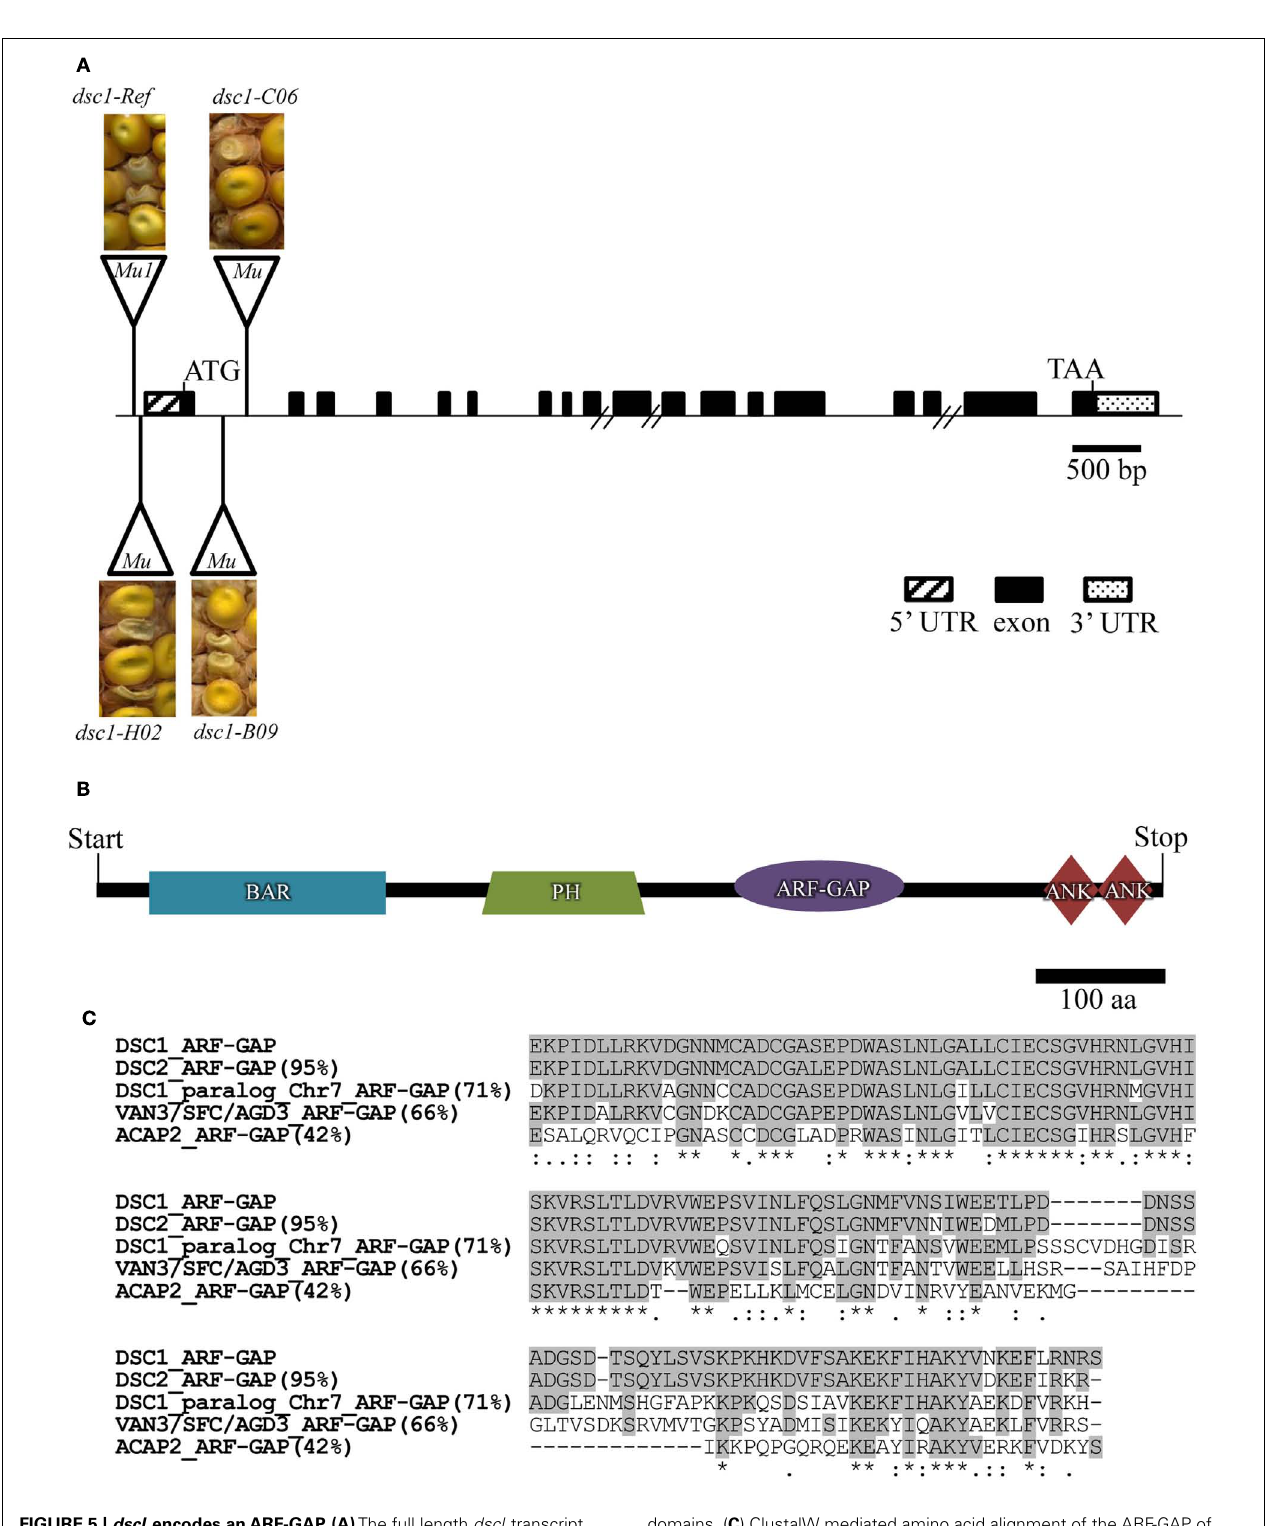
FIGURE 5 | dscl encodes anARF-GAP. (A) The full length dscl transcript is 3.194 kb. Positions of Mu transposon insertions in individual dscl mutant alleles with images of their kernel phenotypes from failed complementation crosses are indicated. Hash marks denote unknown lengths of genomic fragments. (B) The DSC1 protein comprises 823 amino acids and is composed of a BAR, a PH, an ARF-GAP, and two ANKYRIN